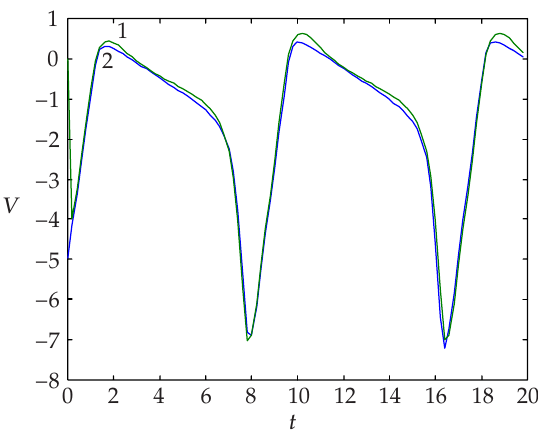
Figure 4.1 . Reconstructed ( 1 ) and original ( 2 ) solutions for the ac- tion